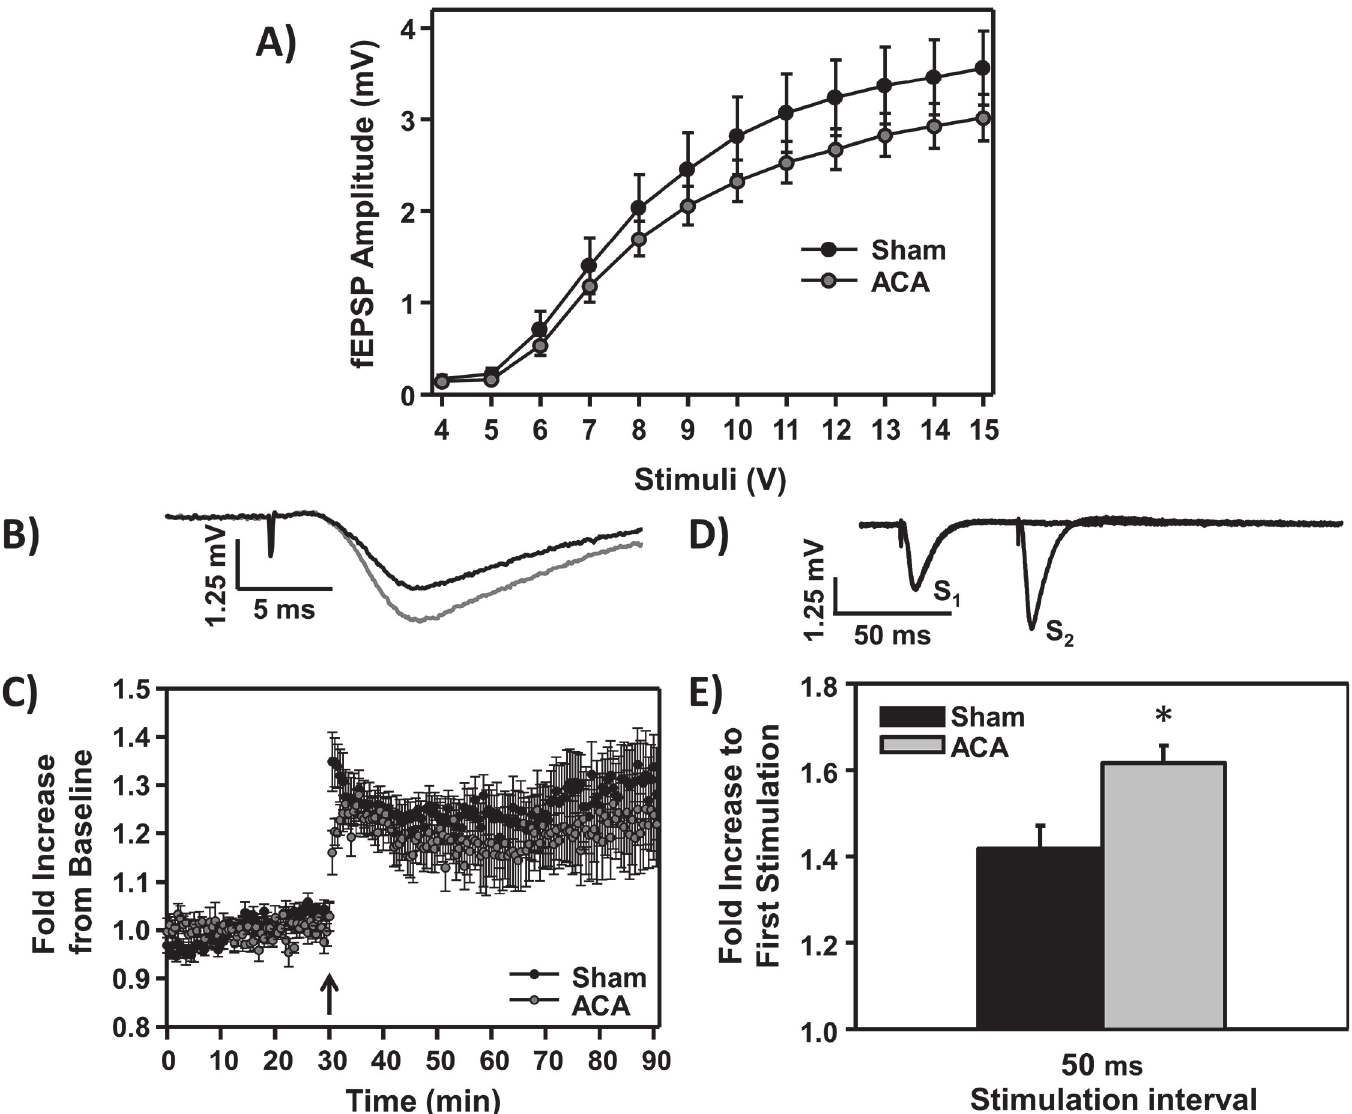
Fig 3. Hippocampal acute slice electrophysiology seven days following Sham or ACA procedure. A) Mean ( ± S.E.M.) input/output curve (I/O) of fEPSP amplitudes across stimulation intensities (4 – 15 V) in control and ACA animals (not normalized). B) Example tracings of sham fEPSP recorded in the CA1 stratum radiatum region of hippocampal slices, before (black) and after (gray) LTP-induction. C) Average slope of fEPSP (averaged to the 30 min pre- tetanus values) before and after the induction of LTP. LTP was induced by 100-Hz tetanic stimulation for 1 s and is indicated by the arrow. D) Example tracings of sham paired-pulse response. E) Average fold increase of paired-pulse response; Stimulation 2 (S 2 )/Stimulation 1 (S 1 ) amplitude following sham and ACA procedures ( * p < 0.05, n = 6).